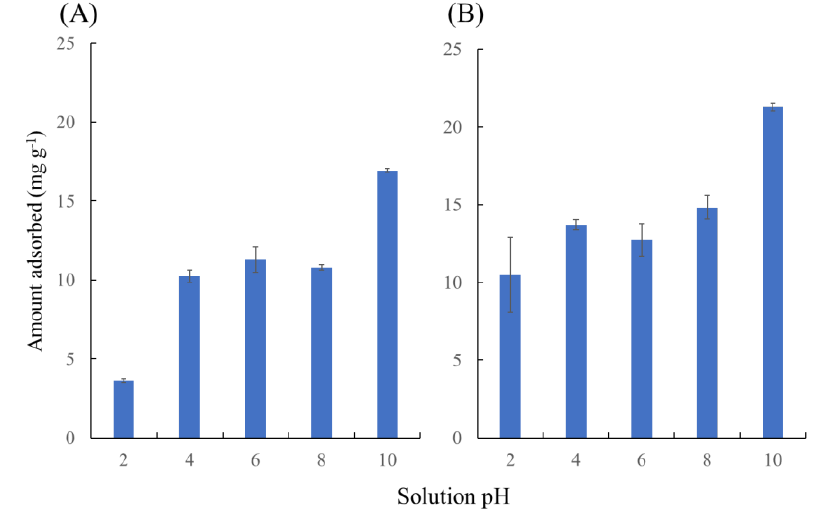
Figure 5. Effect of pH on the adsorption of As(III) using NA11(A) and NAZ1(B). Initial concentration 100 mg L − 1 , solvent volume 50 mL, adsorbent 0.1 g, pH 2, 4, 6, 8, and 10, contact time 24 h, temperature 25 °C, agitation speed 100 rpm.